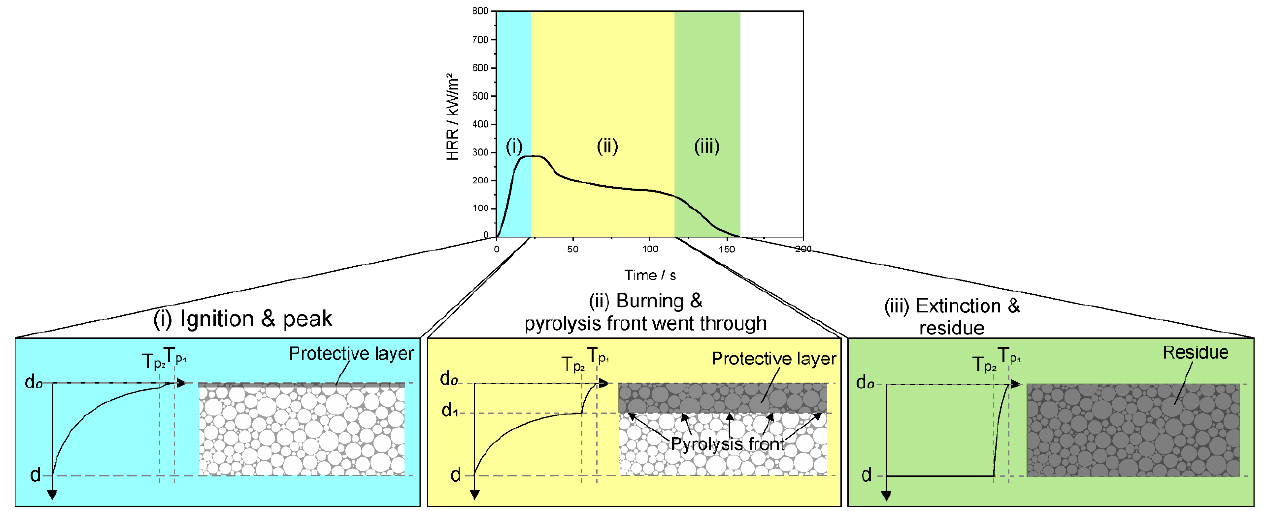
Figure 3. Temperature–thickness relationship of rigid polyurethane foams during different burning stages.